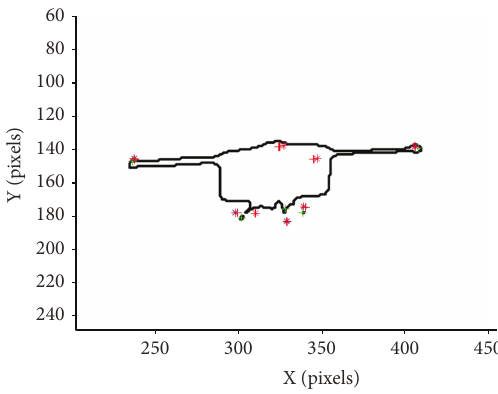
Figure 12: The process of relative position determination. The asterisks are the pictures of the initial approximation of the reference marks; daggers are the reference mark estimation.